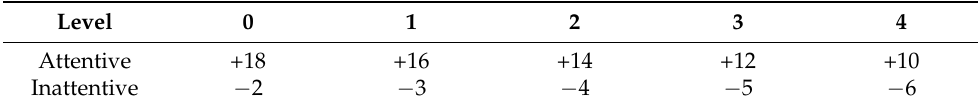
Table 1. Values added/subtracted to global score in each level of the game according to the level of attention.